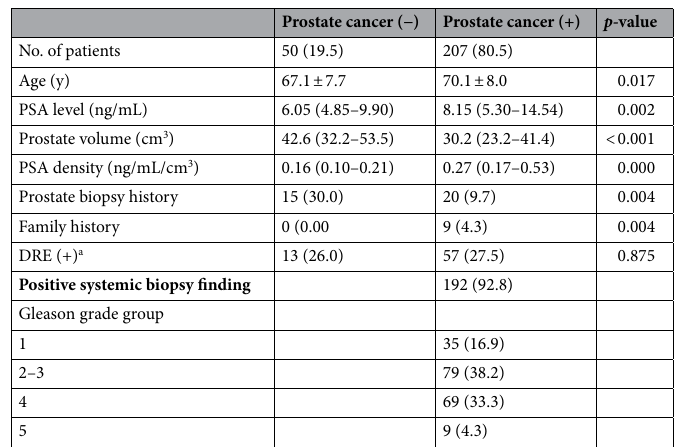
Table 1. Baseline characteristics of patients who underwent prostate MRI-targeted biopsy. Data are presented as number (%), mean ± standard deviation, and median (interquartile range). a DRE ( +) is defined as a palpable nodule or hard surface. DRE, digital rectal exam; PSA, prostate-specific antigen.